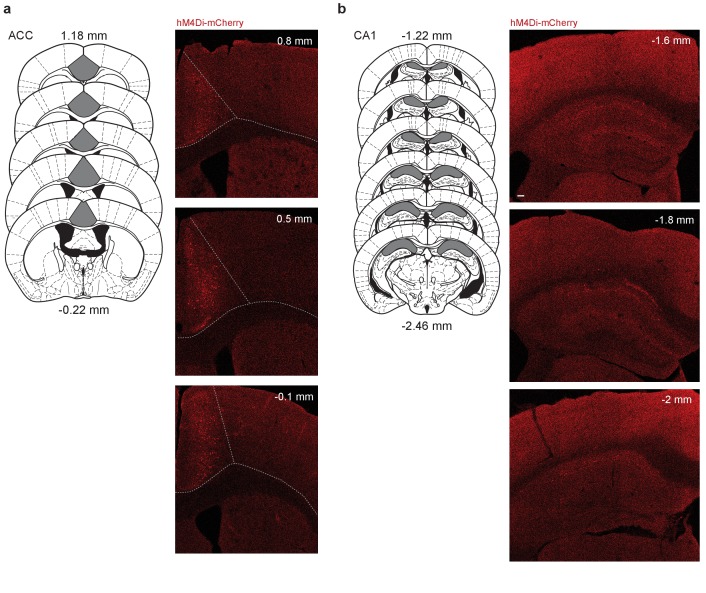
Representative spread of hM4Di-mCherry infection in ACC and CA1.(a) Schematics showing estimates of hM4Di-mCherry expression, and additional representative images of infection in PV-Cre mice micro-infused with AAV8-hSyn-DIO-hM4Di-mCherry in ACC, or (b) dorsal CA1 (scale bar = 100 μm).